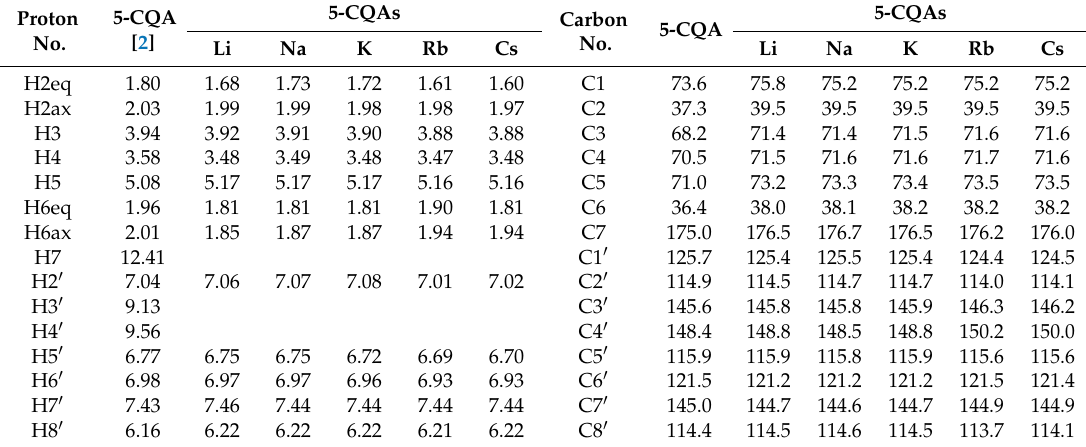
Table 2. The chemical shifts from of 1 H and 13 C NMR (nuclear magnetic resonance) spectra of chlorogenic acid (5-CQA, 5- O -caffeoylquinic acid) and alkali metal chlorogenates (5-CQAs), δ [ppm]. Proton No.